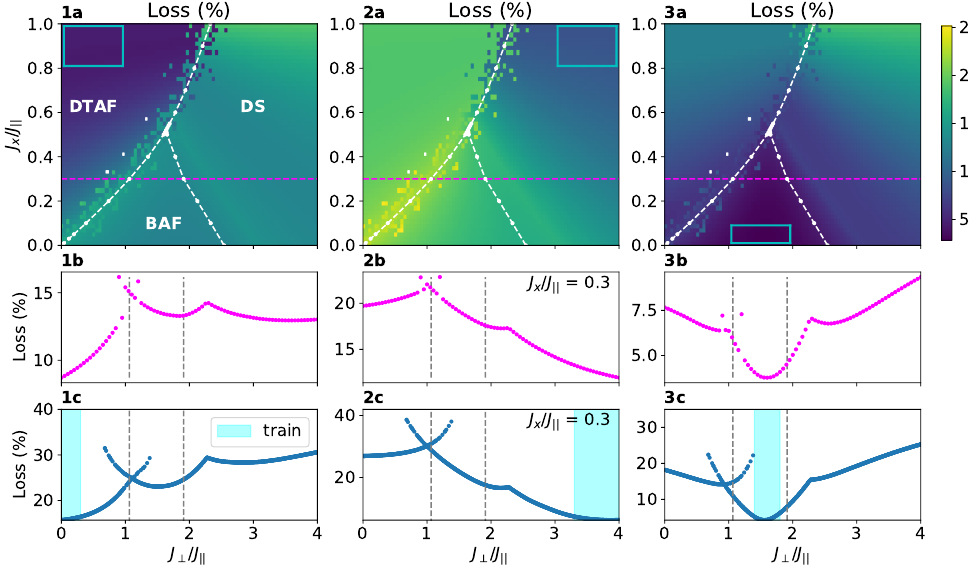
Figure 1: Three training iterations to map out all three phases of the phase diagram without contraction and prior knowledge of the system, i.e. using simple update al- gorithm starting from random initial iPEPS. The cyan rectangles show the training regions. Overlayed in white are theoretical predictions, extrapolated to the infinite D limit with full update optimization from [ 40 ] . Deviations of the second order BAF- DS transition are expected due to finite D = 6 and simple update optimization. 1a) Starting the training at the top-left (in DTAF phase) yields the first-order transition line. Even the second order transition line is already pronounced inside the region of higher loss beyond the first order line. 2a) Second iteration in the region of high- est loss (DS phase) from the previous picture showing the part of the first order line adjacent to the DS phase and the second order line. 3a) Confirming and completing the picture by training in the BAF phase. The second row (1b-3b) is a single cut as indicated by the magenta line in the phase diagram above. The third row (1c-3c) shows the loss after training and evaluating extra single cut data with five indepen- dent simulations per data point. Around the first order transition two branches are obtained due to the characteristic hysteresis